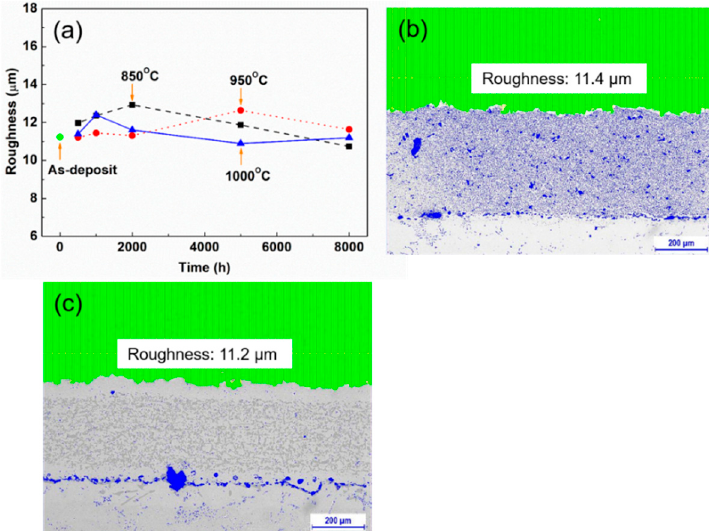
Figure 3. ( a ) The evolution of roughness on the surface between a TBC and bond coating for a variety of isothermal heat exposures and the post-processed optical microscope images representing a slight variation in the roughness on the surface between the TBC and bond coating exposed to ( b ) 500 h and ( c ) 8000 h at a constant temperature of 1000 °C.